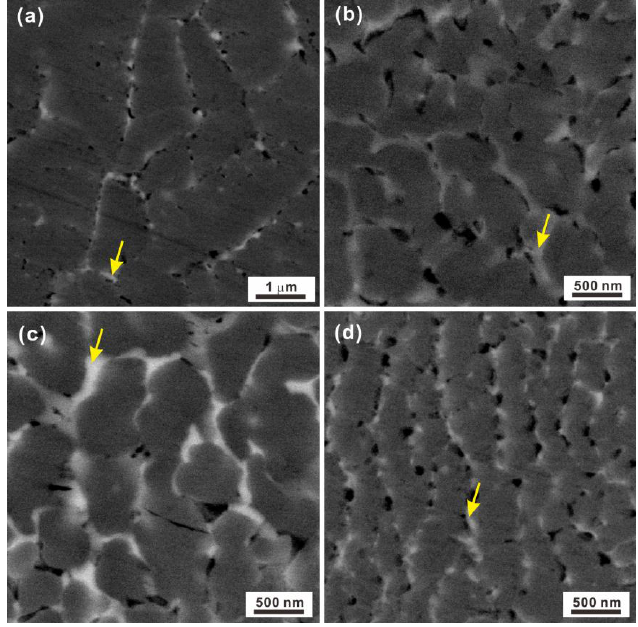
Figure 3. Backscattered scanning electron microscopy (SEM) images of crystals in the glassy matrix of the ( a ) T1, ( b ) T2, ( c ) T3, and ( d ) T4 rods. Table 1. Values of T g , T x , and Δ T rg for the melt-spun ribbons (recorded at 20 K/min heating rate) and the corresponding volume fractions of crystals f c 1 and f c 2 of the as-cast rods as determined from DSC measurements and optical microscopy, respectively.